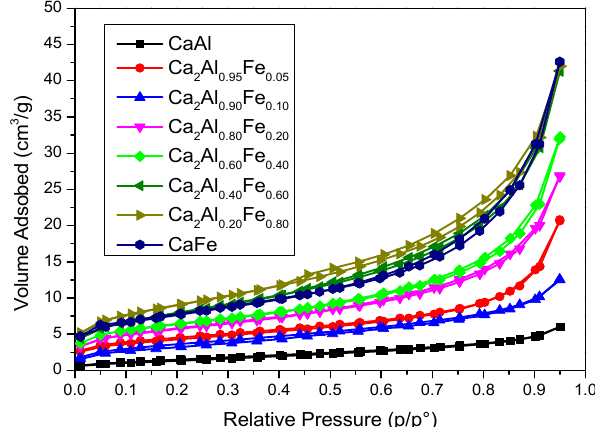
Figure 5. Nitrogen adsorption–desorption isotherms of the samples.